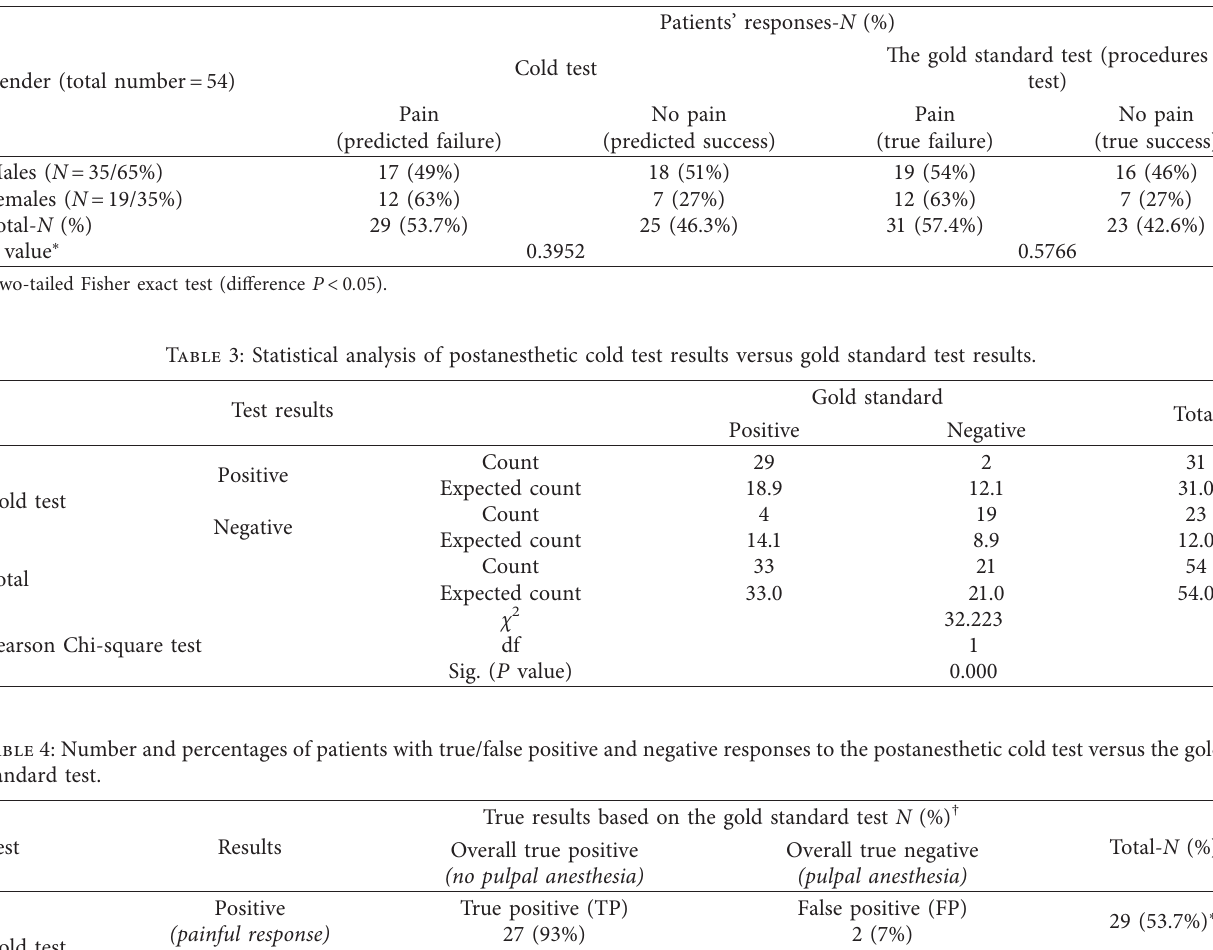
Table 2: Comparison between pain perception of male and female patients to postanesthetic cold test and gold standard test, and the overall percentage of pulpal anesthetic failure and success.